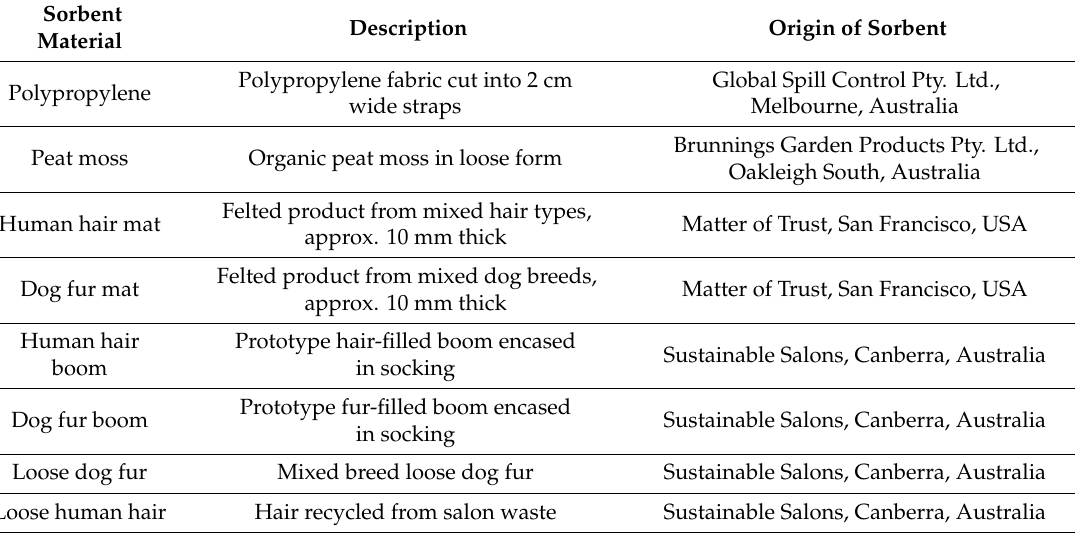
Table 1. Oil spill sorbents used in microcosm experiments.